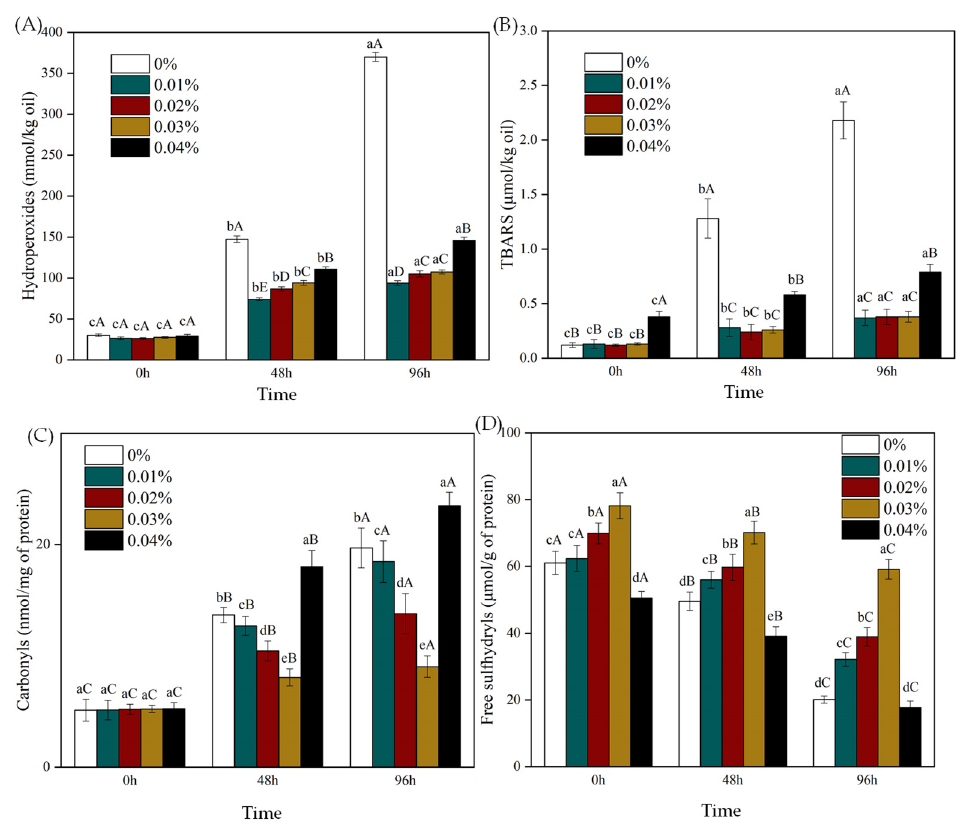
Figure 6. Generation of lipid hydroperoxides ( A ), thiobarbituric acid reactive substances ( B ), protein carbonyls ( C ), and free sulfhydryls ( D ) in emulsions containing different levels of (-)-epigallocatechin- 3-gallate during storage. Means with different letters (a–d, A–E) within the same parameter group differ significantly ( p <